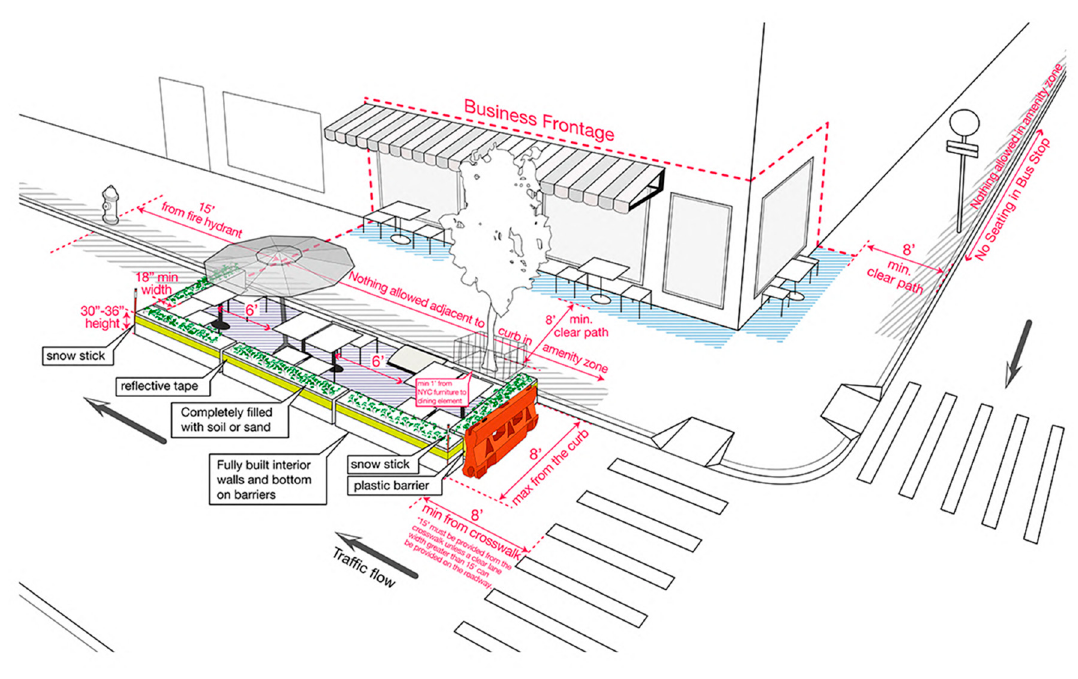
Figure 1. This DOT depiction shows the basic rules for street constructions (Source: NYC DOT)